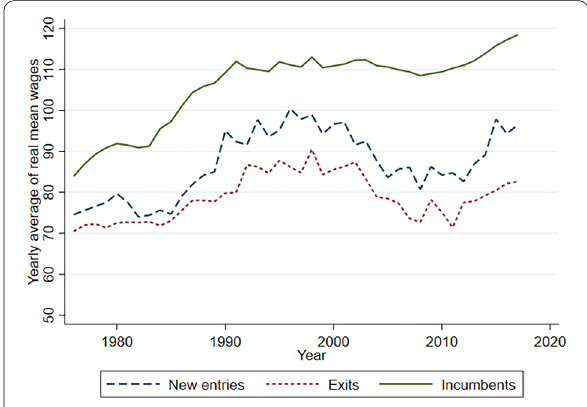
Fig. 9 Mean establishments’ wages in real terms in West Germany, weighted by establishment size